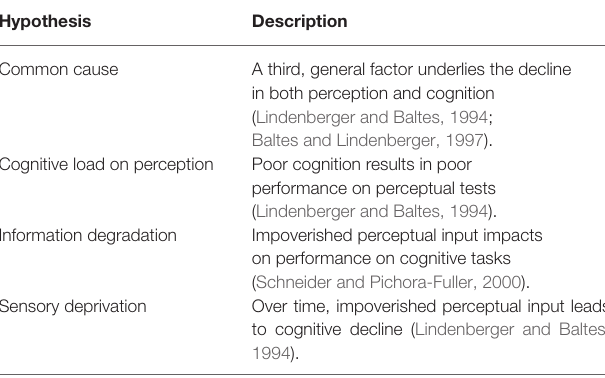
TABLE 1 | Proposed hypotheses for the link between perceptual and cognitive decline in old age. Hypothesis